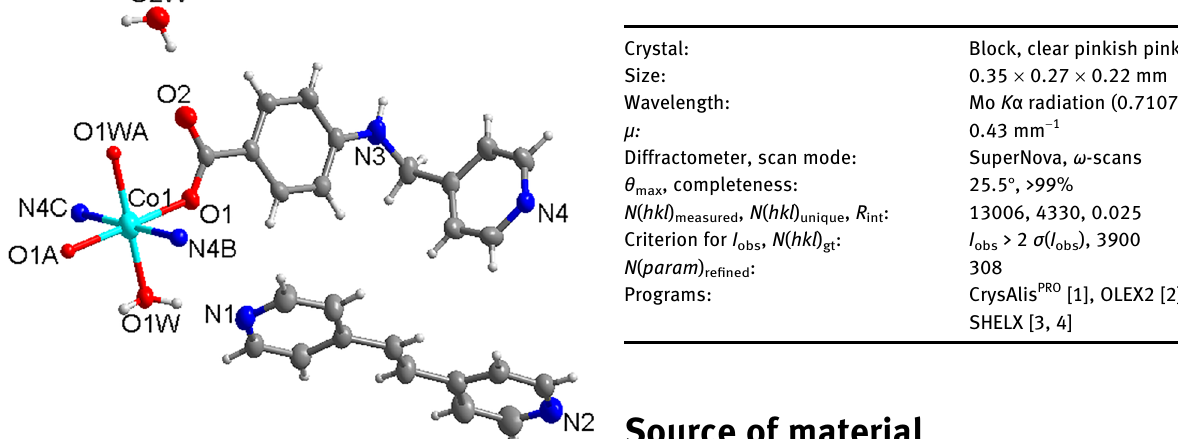
Table  : Data collection and